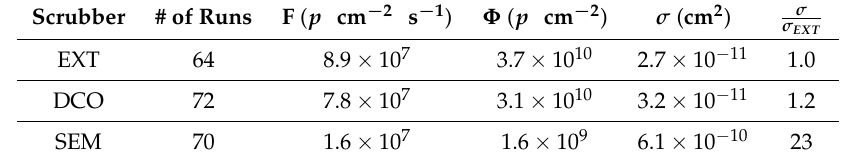
Table 2. Summary of test conditions, fluence to failure and cross section for the three tested scrubbers.